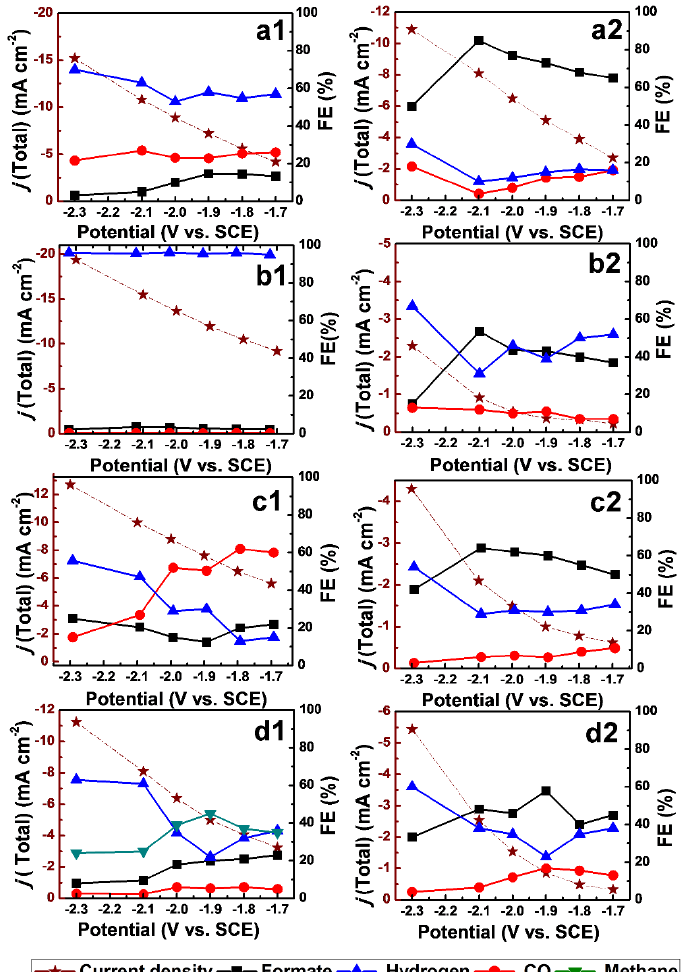
Figure 3. Catalytic activities of metal and amalgam catalysts during the CO 2 reduction at various constant potentials in a CO 2 saturated 0.1 M KHCO 3 solution ( a1 ) Faradaic efficiencies of HCOO − , CO and H 2 at Pd ( a2 ) Faradaic efficiencies of HCOO − , CO and H 2 at PdHg800, ( b1 ) Faradaic efficiencies of HCOO − , CO and H 2 at Pt. ( b2 ) Faradaic efficiencies of HCOO − , CO and H 2 at PtHg800, ( c1 ) Faradaic efficiencies of HCOO − , CO and H 2 at Au, ( c2 ) Faradaic efficiencies at AuHg800, ( d1 ) Faradaic efficiencies at Cu and ( d2 ) Faradaic efficiencies at CuHg800 .